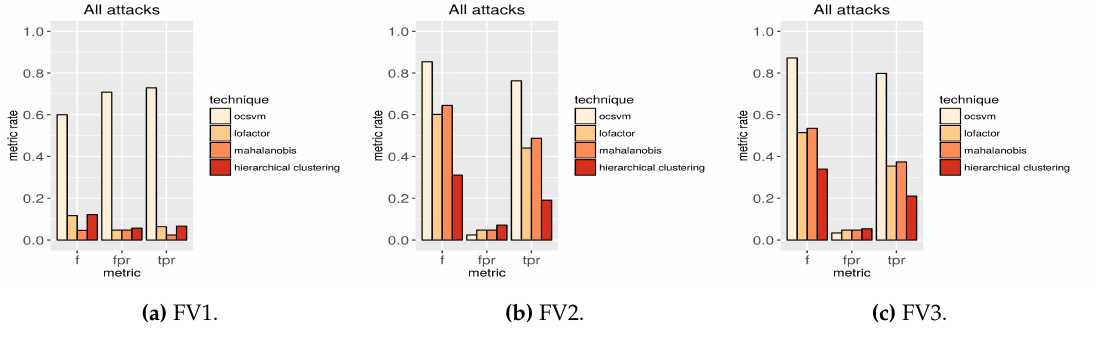
Figure 4. Results using the test dataset with samples of all the attacks filtering the features according to the three feature vector definitions with a very restrictive PFPR. The plots show the metrics f-score (f), the false positive rate (fpr) and the true positive rate (tpr). The captions below each plot indicate the feature vector definition used in each case.